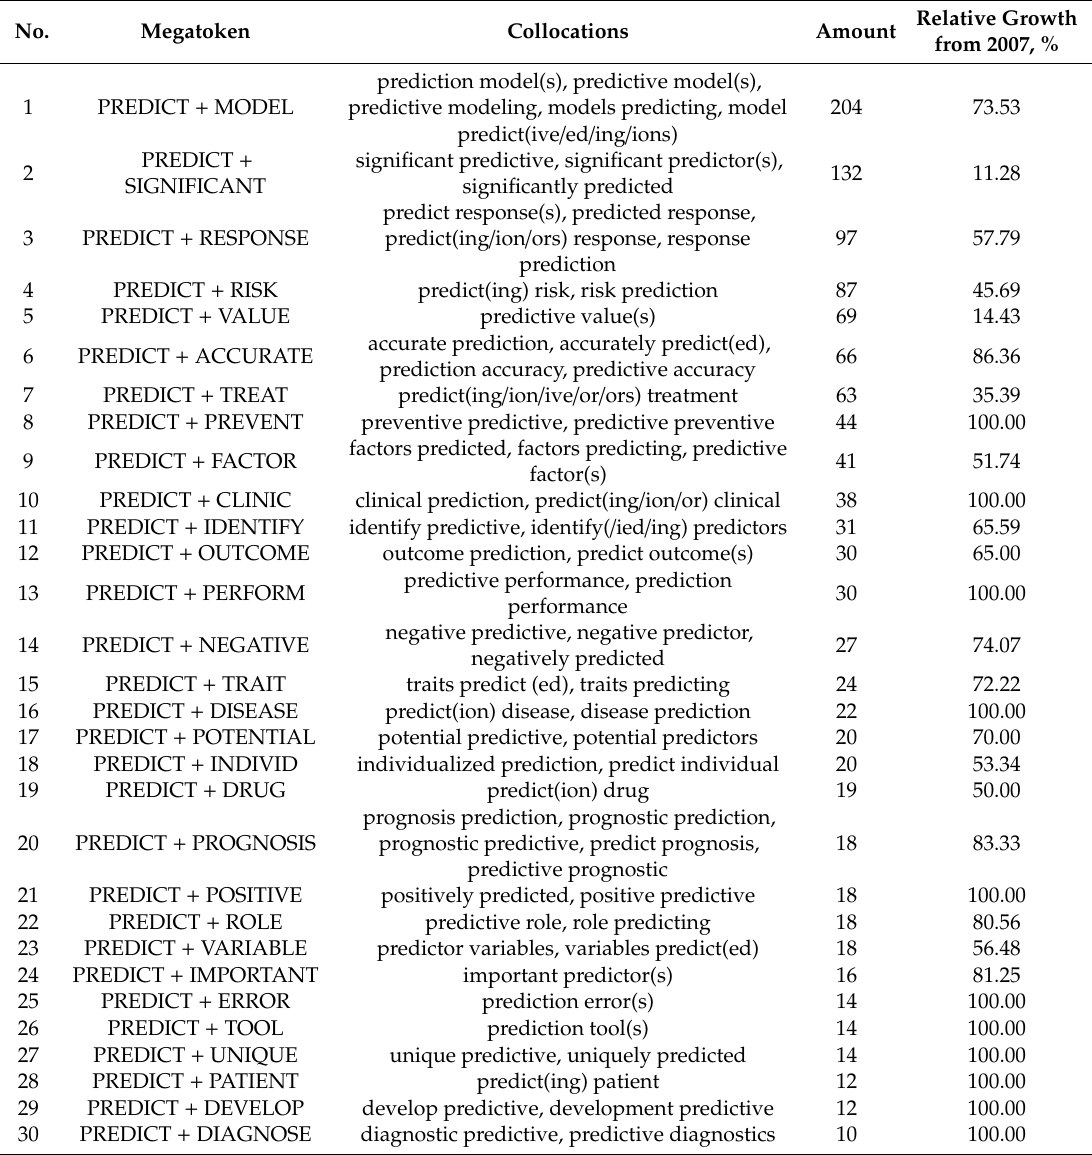
Table 2. Key collocations with derivatives that have the root “predict” extracted from the PubMed database for the period from 2007 to 2019 (green color in